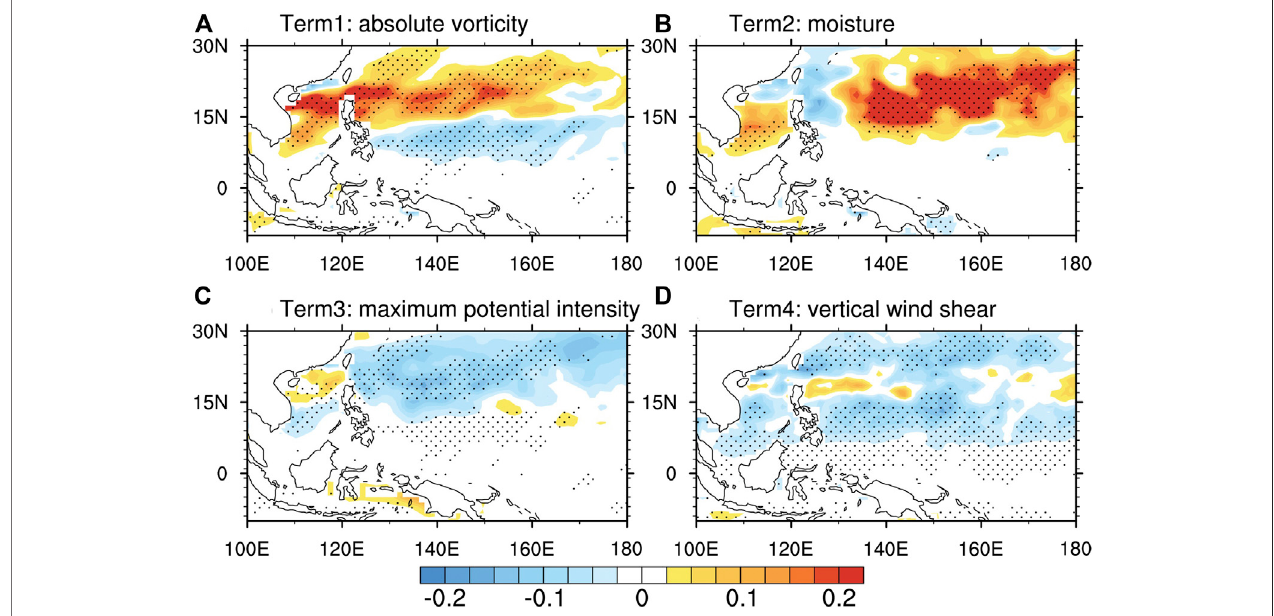
FIGURE 10 | The composite difference of four independent δ GPI (GPI anomaly) terms in the active phase minus those in the inactive phase. (A) Term1 represents vorticity, (B) Term2 representsmoisture, (C) Term3 represents potential intensity, and (D) Term4 represents vertical wind shear. The dots represent values signi fi cantat the 95% con fi dence level using the t